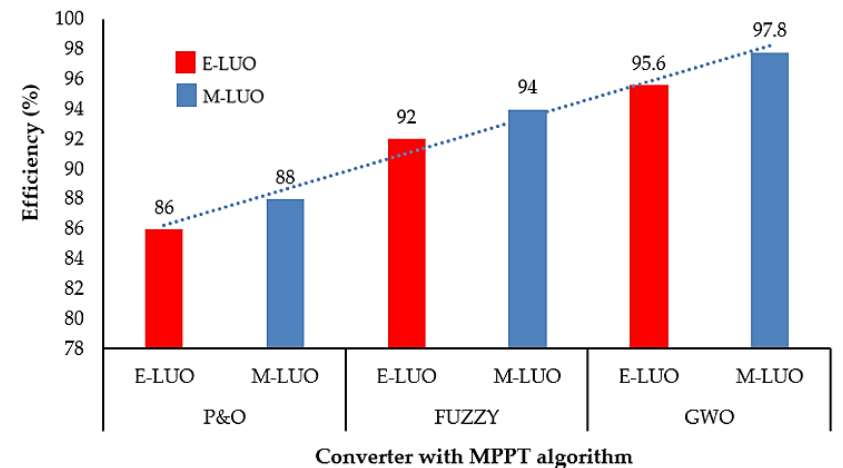
Figure 14. E ffi ciency comparison of the di ff erent MPPT methods for the elementary and modified LUO Figure 14. Efficiency comparison of the different MPPT methods for the elementary and modified converters (E-LUO and M-LUO). LUO converters (E-LUO and M-LUO).